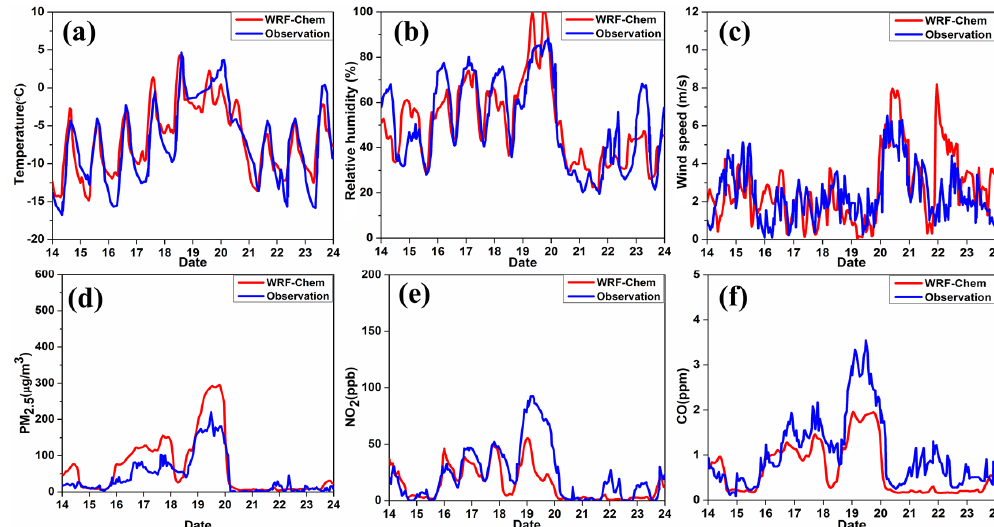
Figure 3. Simulated and observed hourly temperature, RH, wind speed, PM 2 . 5 , NO 2 and CO in the Shangdianzi (SDZ) station.